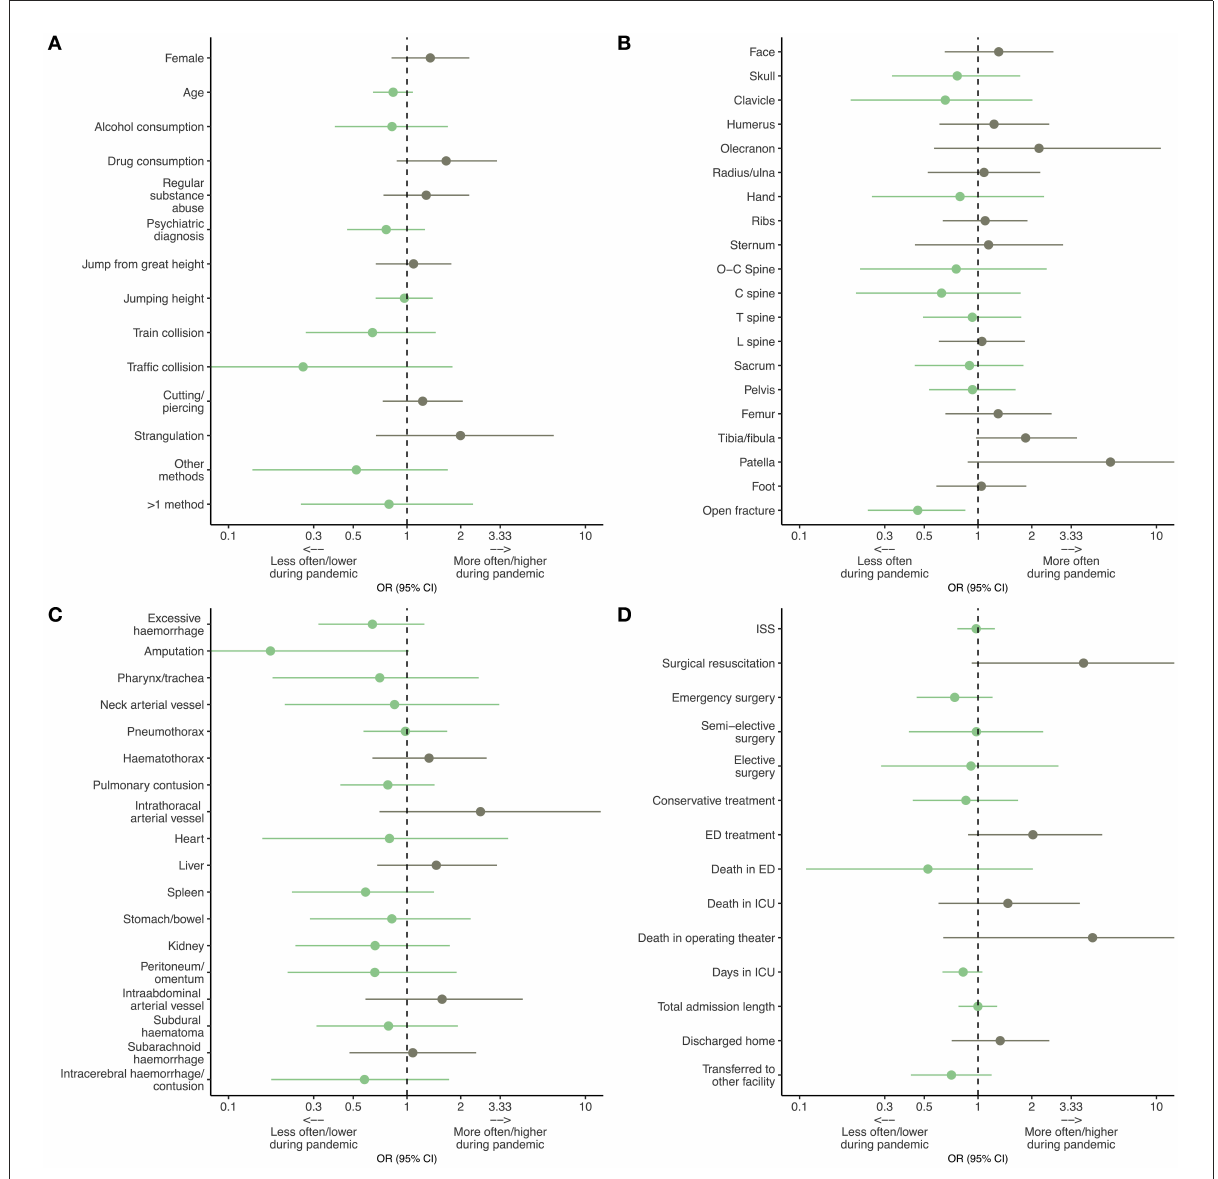
FIGURE3 Odds ratios (ORs) for (A) demographics and suicide methods, (B) osseous injury patterns, (C) non-osseous injury patterns, (D) Injury Severity Score (ISS), treatment and outcomes of patients who undertook serious violent suicide attempts (SVSAs) during the COVID-19 pandemic and a proceeding control period. Green confidence intervals (95% CIs) indicate an event happening less often during the pandemic, whereas gray 95% CIs represent events happening more often during the pandemic. To obtain symmetric CIs, a log-scaled x-axis was used (few, very wide CIs were cut for proper display). ED, emergency department; C spine, cervical spine; ICU, intensive care unit, L spine, lumbar spine, O-C spine, occipito-cervical spine, T spine, thoracic